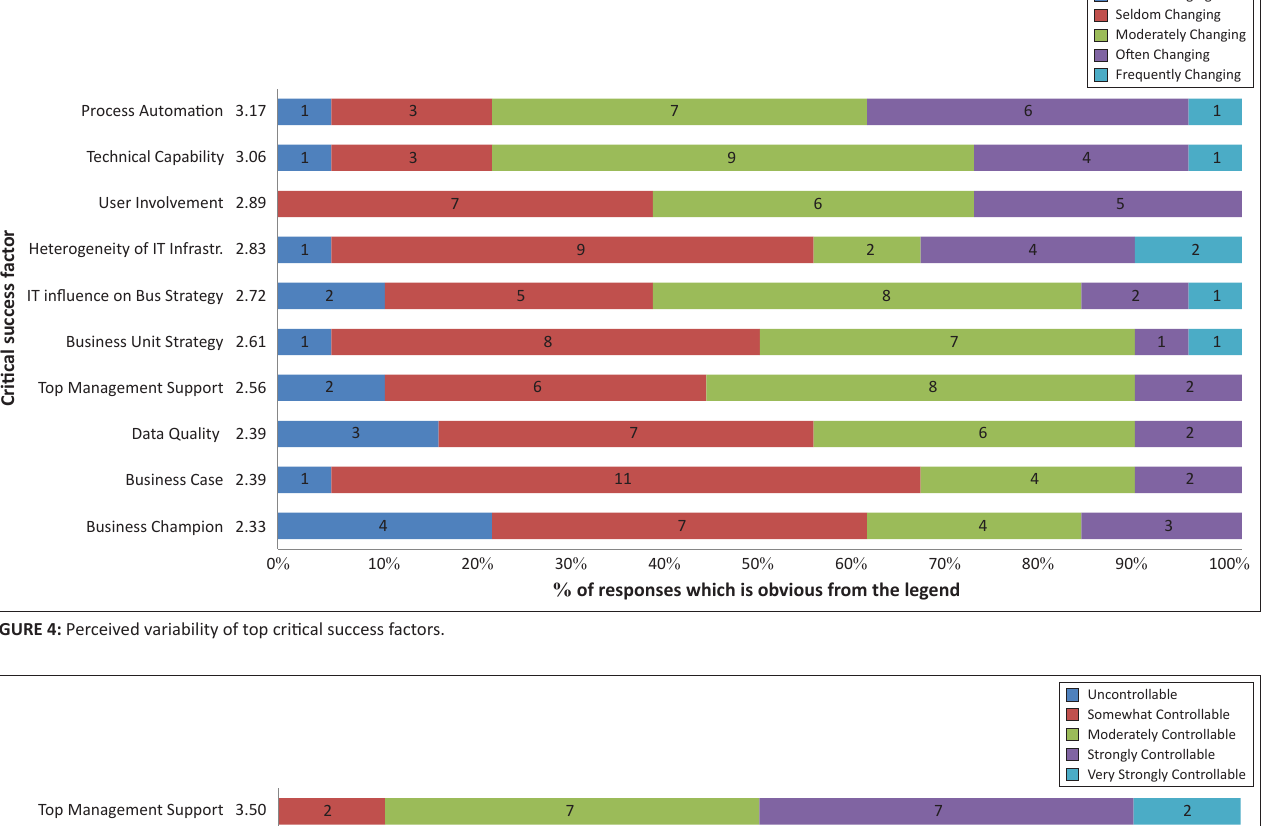
Top Management Support 3.50